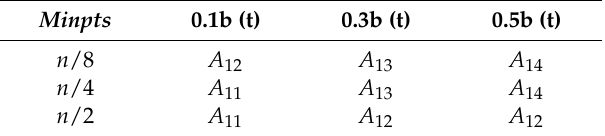
Table 5. Effect of 𝑀𝑖𝑛𝑝𝑡𝑠 on detection time, with Euclidian distance, 17 features, 𝜀 = 0.094 .